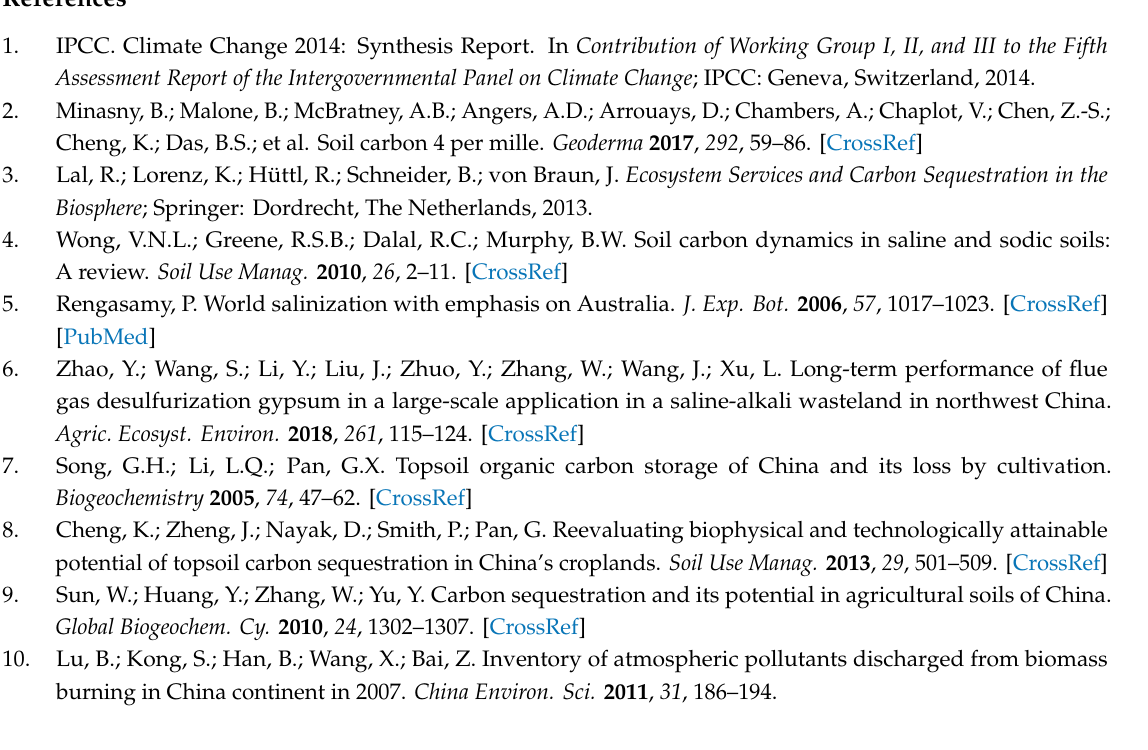
Table S1: Mean values in corn production, soil chemical properties, carbon, nitrogen, and C / N after harvest of maize with di ff erent application rate in F1, F2, F3, F4, and